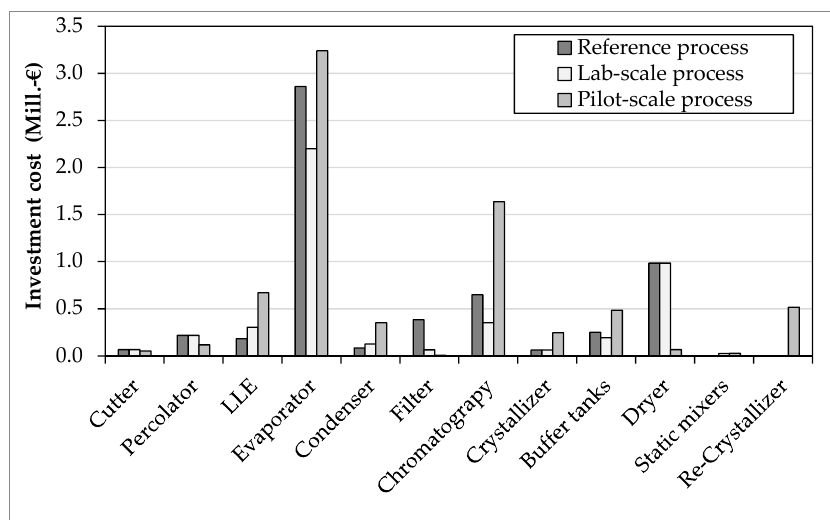
Figure 5. Summary of the investment costs.